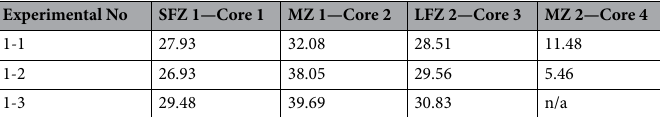
Table 5. Percentage of residual reserves at the end of Group I